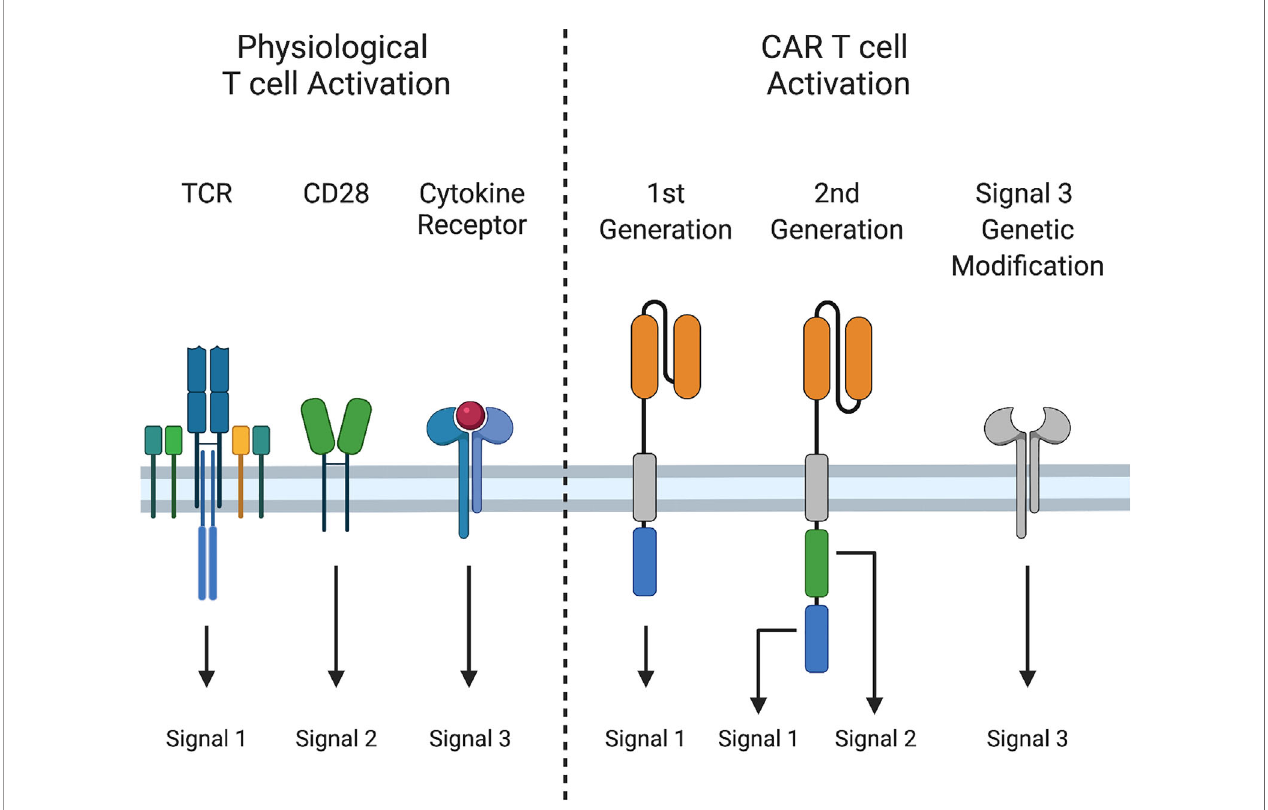
FIGURE 2 | Signals 1, 2, and 3 in T cell activation. Physiological T cell activation and sustained effector function require i) Signal 1: peptide-MHC recognition and signaling through the T cell receptor (TCR), ii) Signal 2: costimulation through CD28, and iii) Signal 3: cytokine stimulation. First generation CARs provide only Signal 1, while second generation CARs provide Signals 1 and 2, and induce cytokine production (Signal 3). Signal 3 can be augmented by additional genetic modi fi